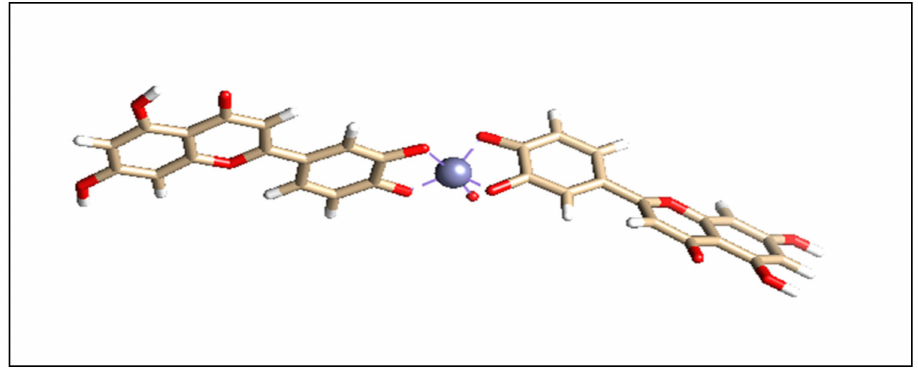
Figure 3. The 3D structure of the optimized